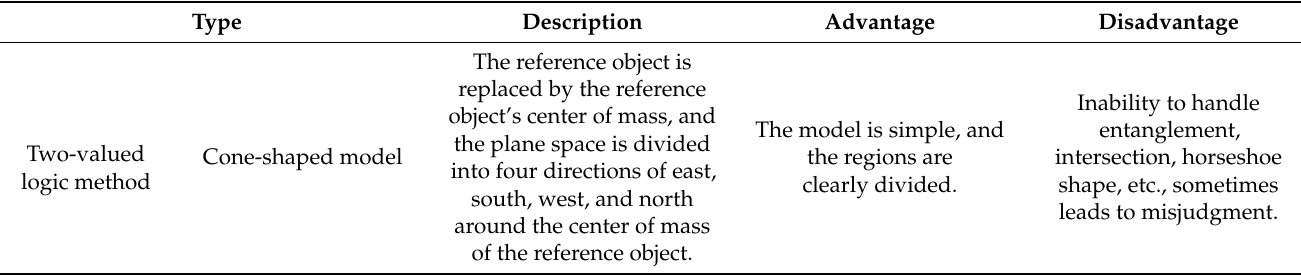
Table 1. The characteristics of the main positioning